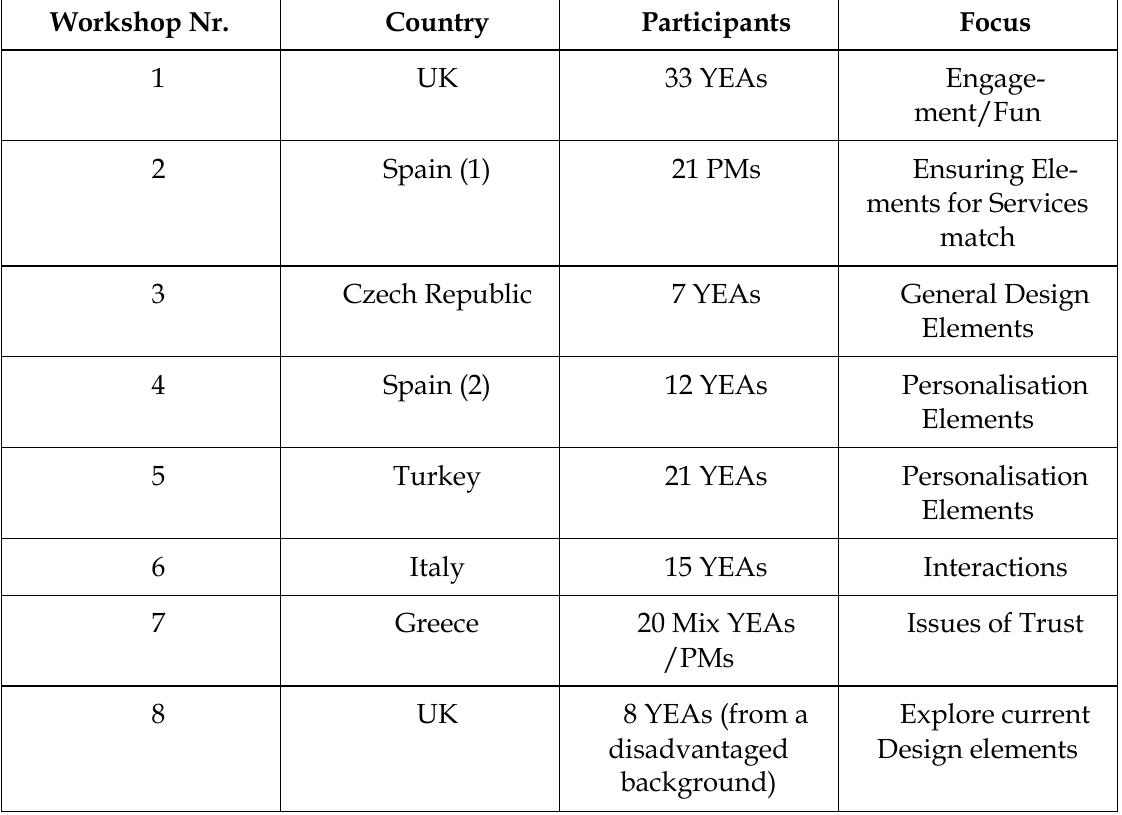
Table 2. Co-creation workshops on Users needs Workshop